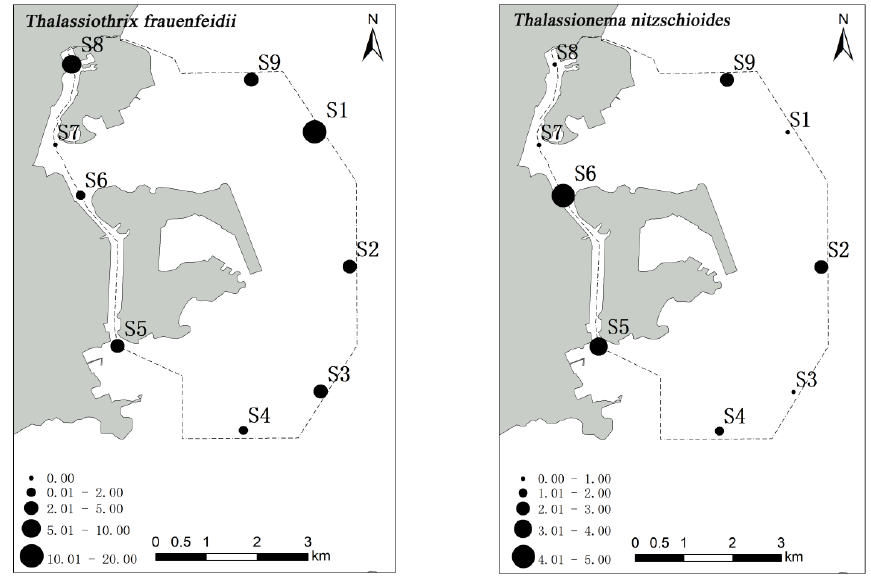
Figure 4. The spatial distribution of abundance (cell/m 3 ) of phytoplankton dominant species in waters around Macau.